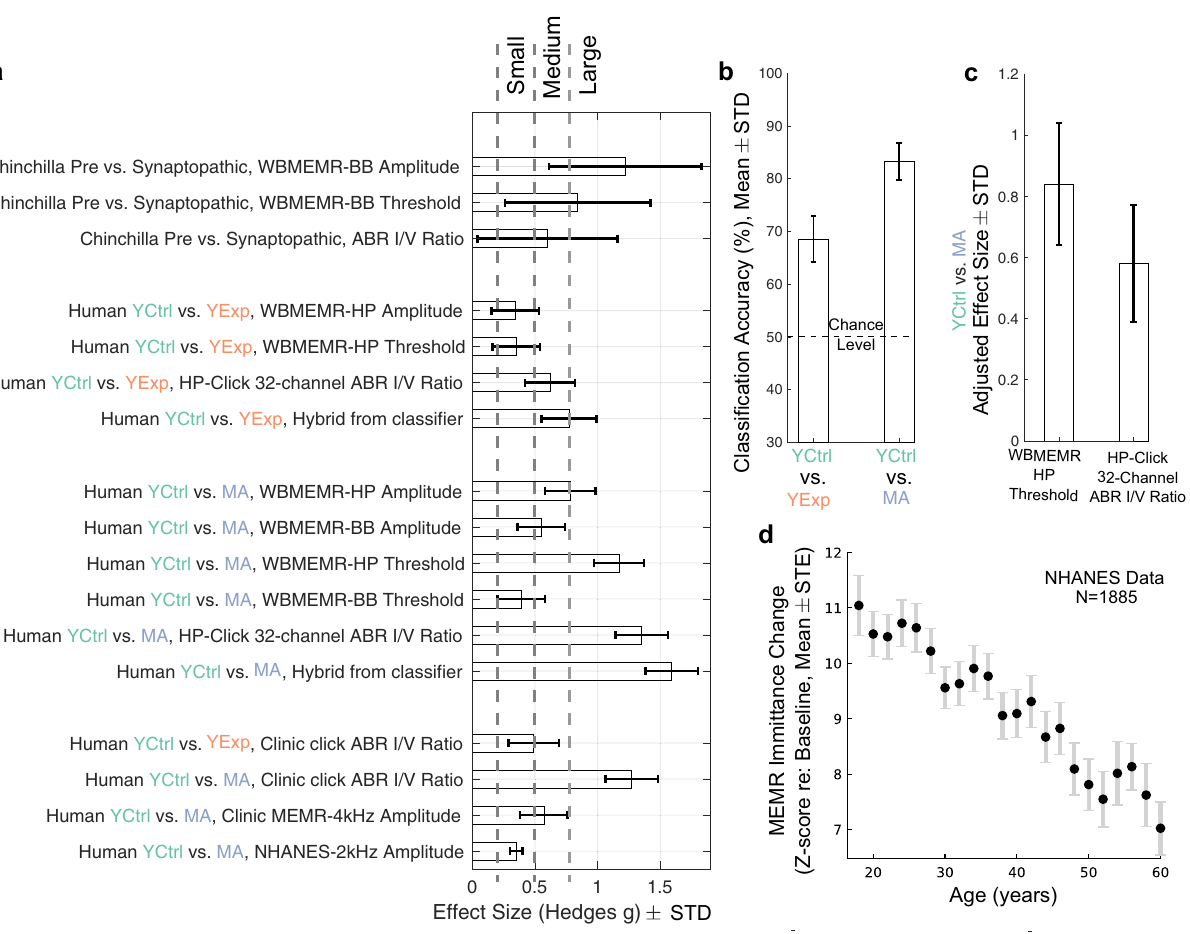
Fig. 3 Clinic-style MEMR and ABR measures are also consistent with CS in high-risk human groups, but less sensitive than lab-style measures. a Effect-size comparisons for individual assays. b An SVM classi fi er performs substantially above chance in blindly classifying individuals into their groups. c Effect size adjusted for audiometric thresholds > 8 kHz is larger for the “ best ” WB-MEMR than the “ best ” ABR metric. d NHANES repository data show steady decline in MEMR amplitude with age despite normal